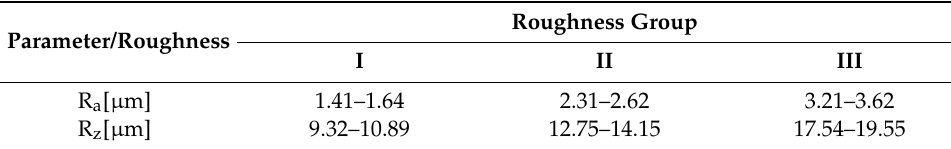
Table 3. Values of steel pin output roughness parameters.